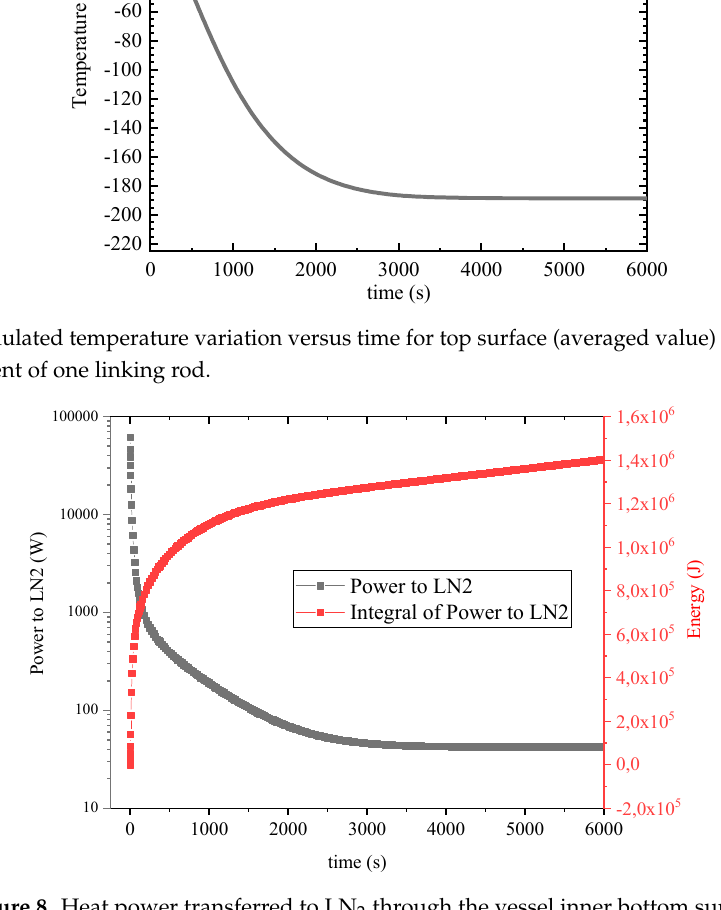
Figure 7. Simulated temperature variation versus time for top surface (averaged value) and for middle section element of one linking rod.